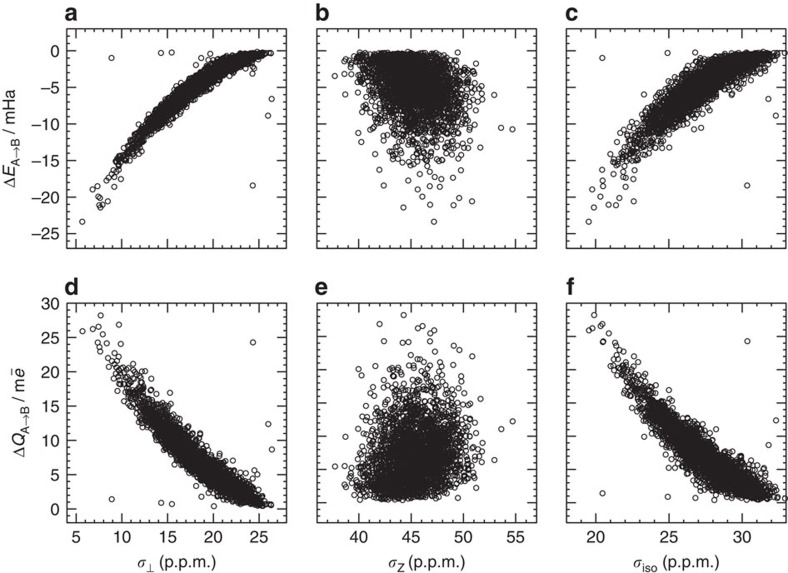
Relationship between the electronic descriptors and NMR characteristics of HBs.ΔEA→B and ΔQA→B as a function of σ⊥, σZ and σiso, respectively.